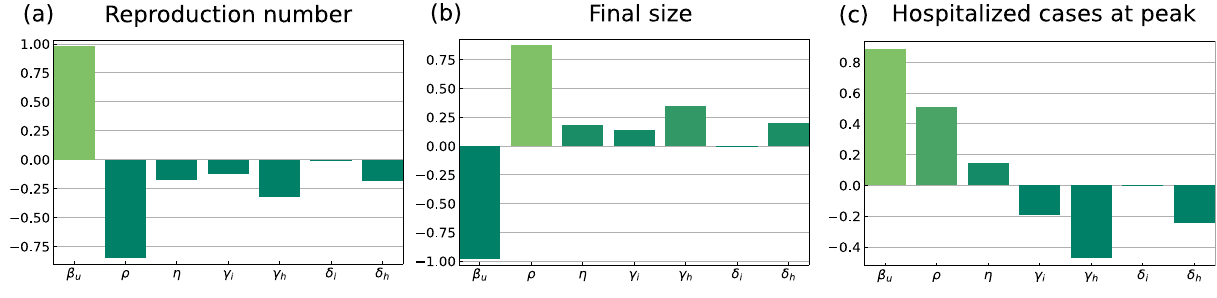
Figure 8. Partial rank correlation coefficients (PRCCs) of seven main model parameters for ( a ) reproduction number, ( b ) final size ( S ∞ ) and ( c ) the number of hospitalized cases at peak in region A. Parameters with PRCC larger than zero are positively correlated with the quantity of interest, whereas parameters with negative PRCC are negatively correlated. Parameters were varied within the ranges given in the Supplementary